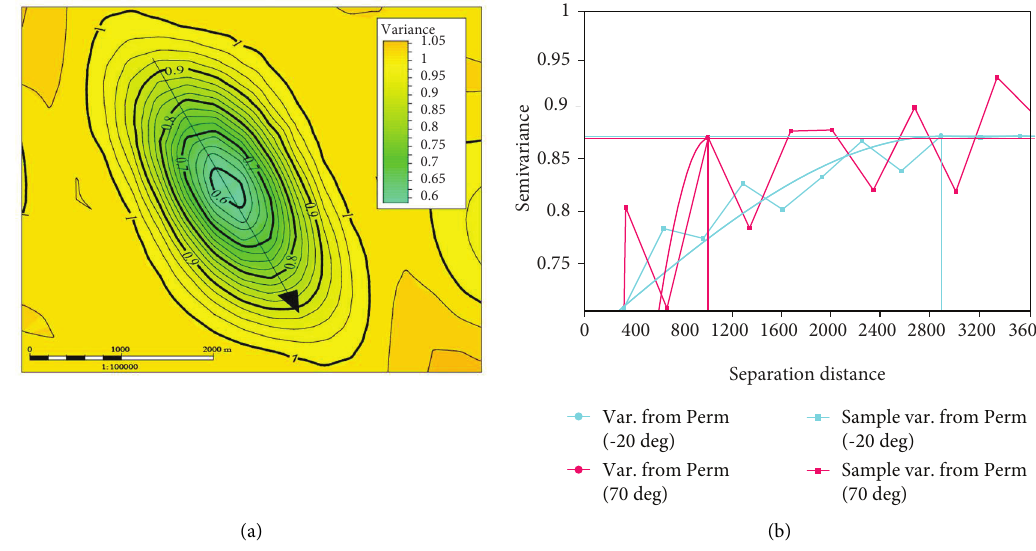
Figure 7: Composite chart of the plane variogram figure of the predicted model. (a) Plan view of variogram in the XY direction of the model (the direction of the arrow is the direction of maximum range). (b) Model output variation fitting graph.